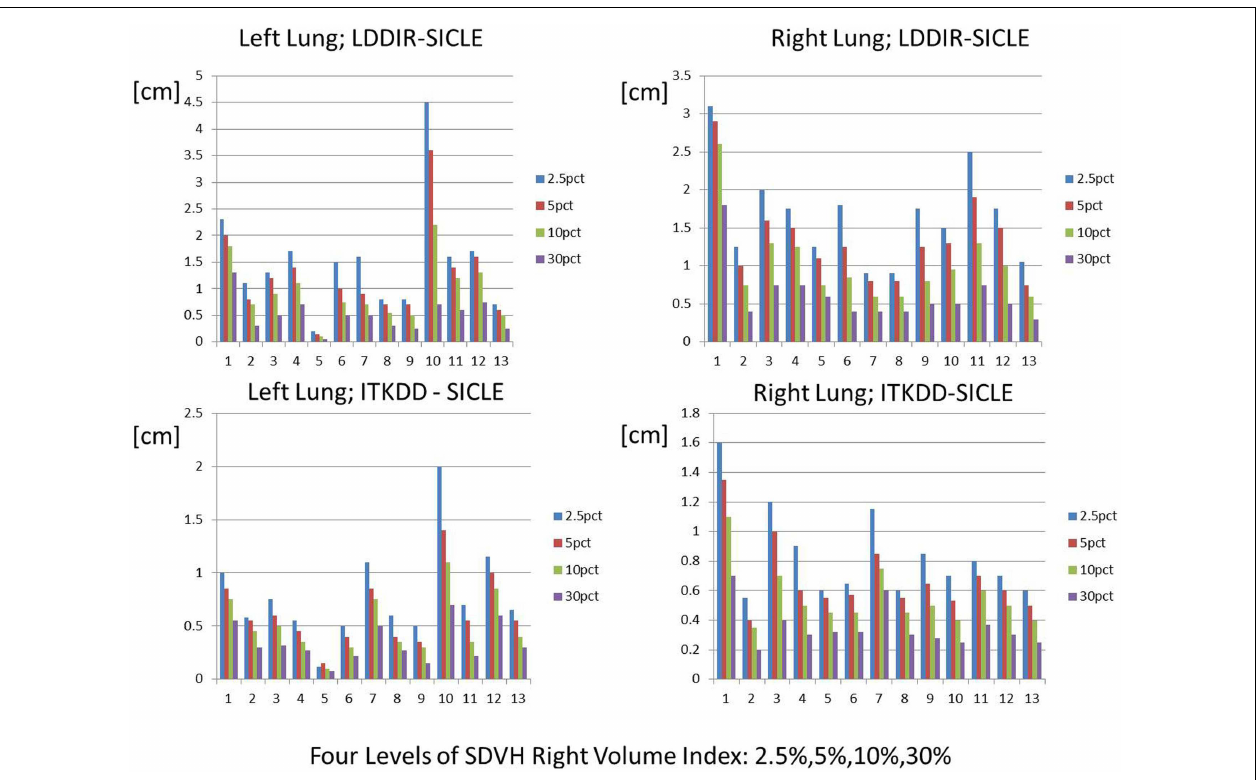
FIGURE 5 | Spatial discrepancy boundaries for a series of volume fractions in both lungs . Data for other structures are summarized in Tables 4 and 5